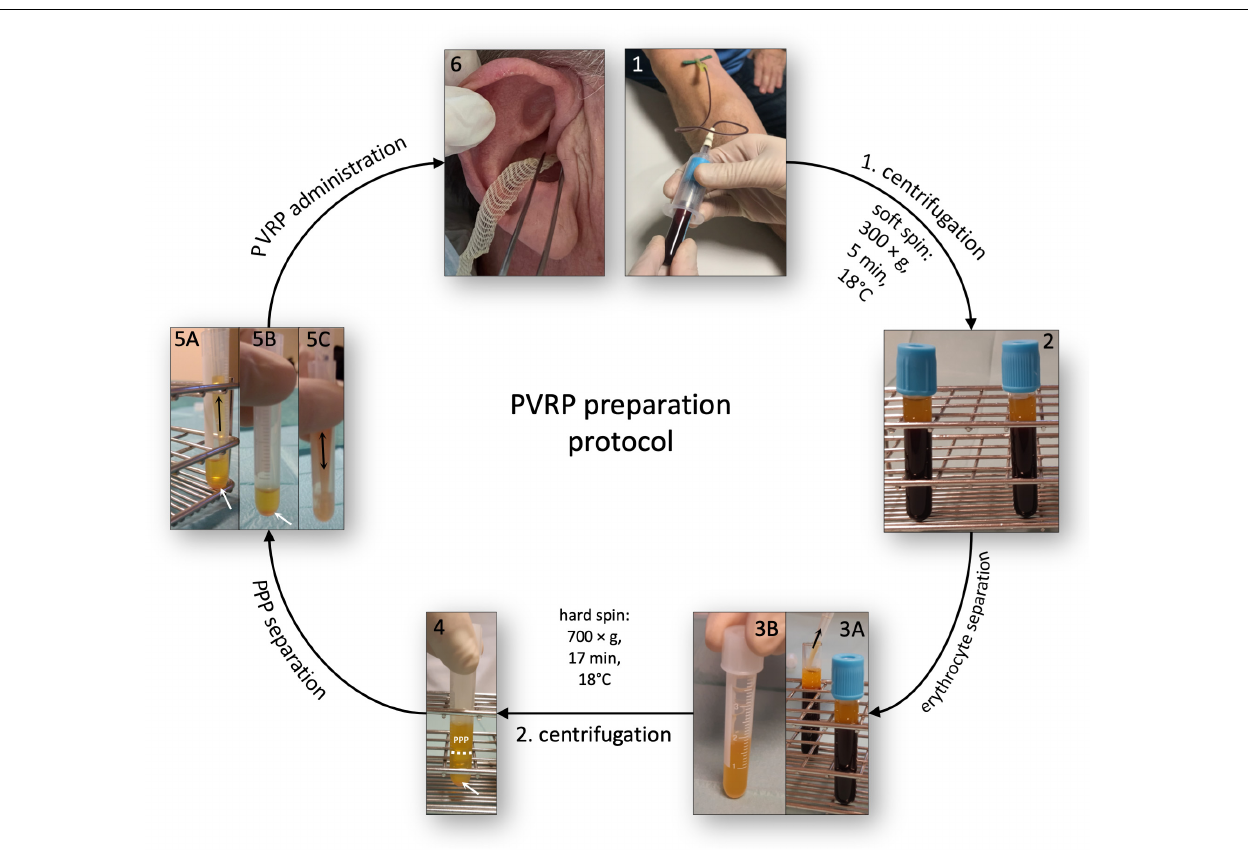
FIGURE 3 | Autologous PVRP preparation protocol. Four citrated blood tubes were used to prepare two units of PVRP in parallel. Panels 1–6 denote preparation steps. PVRP: platelet- and extracellular vesicle-rich plasma; PPP: platelet-poor plasma. Adapted from Vozel et al.